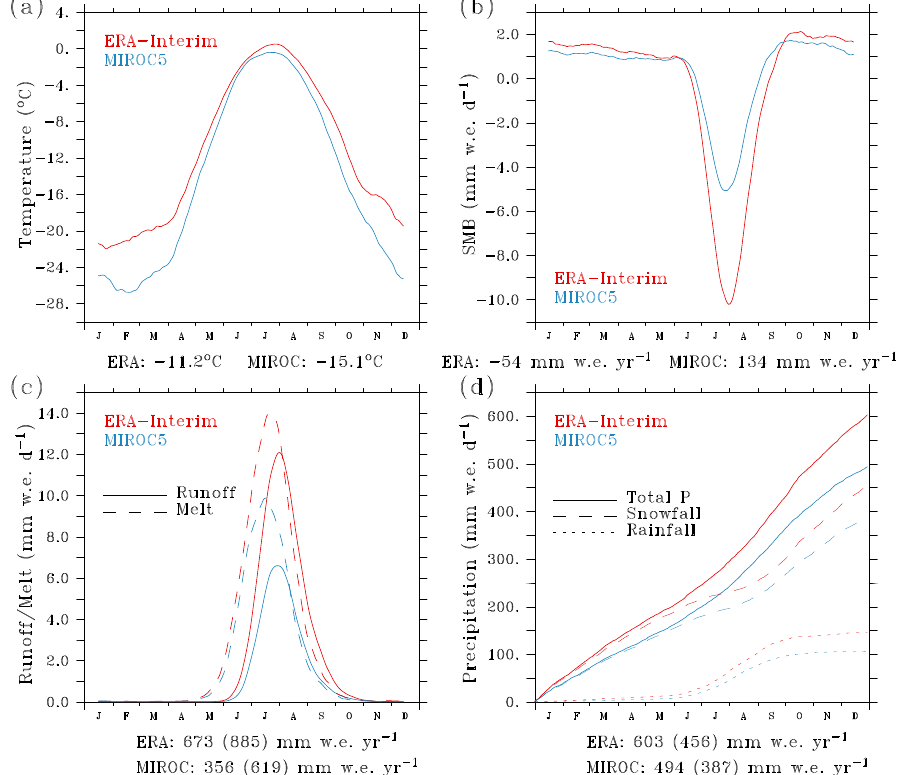
Figure 12. (a) 1980–2005 mean annual near-surface temperature cycle ( ◦ C) for MAR ERA (red) and MAR MIROC5 (blue). A 30-day run- ning mean has been applied to smooth the curves. The numbers give the mean annual temperature integrated over the permanent ice area for MAR ERA and MAR MIROC5 . (b) Same as (a) but for the surface mass balance (mmw . e . day − 1 ). The numbers give the annual SMB (mmw . e . yr − 1 ) integrated over the permanent ice area for MAR ERA and MAR MIROC5 . (c) Same as (a) but for the runoff (solid line) and melt (dashed line) (mmw . e . day − 1 ). The listed numbers give the mean annual runoff, with the melt over the permanent ice area in brackets (mmw . e . yr − 1 ). (d) Same as (a) but for the cumulated total precipitation (solid line), snowfall (large dashes) and rainfall (small dashes) (mmw . e . day − 1 ). The numbers give the mean annual precipitation and snowfall (shown in brackets) over the permanent ice area (mmw . e . yr − 1